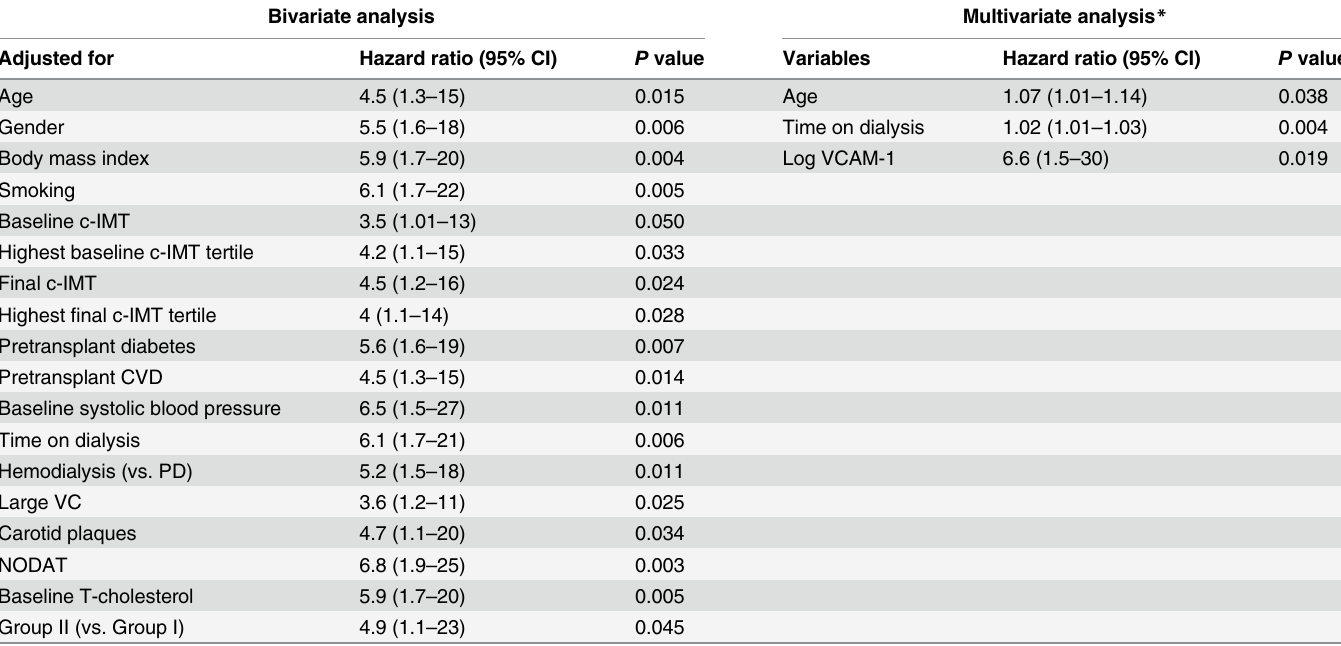
Table 4. Relationship between VCAM protein levels and overall mortality by bivariate and multivariate Cox regression analysis Bivariate analysis Multivariate analysis